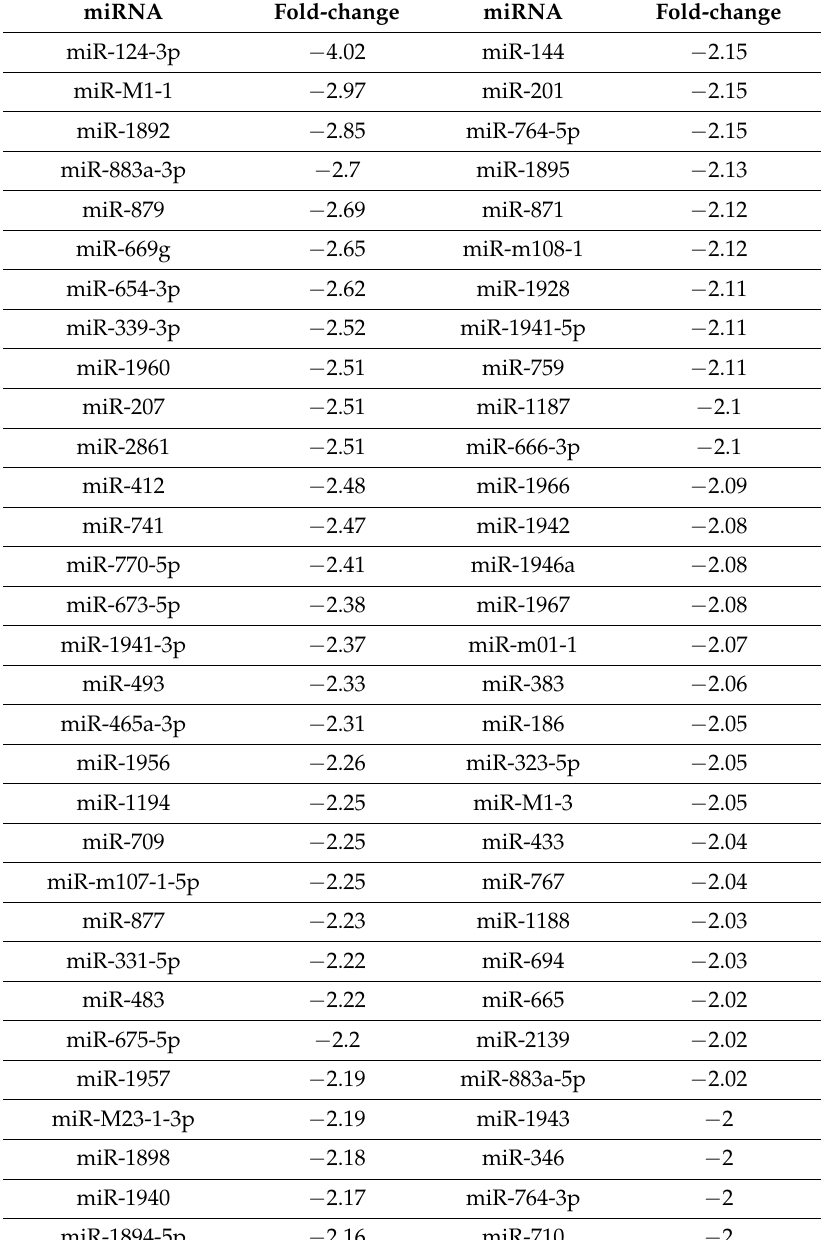
Table 3. Downregulated miRNAs at 24